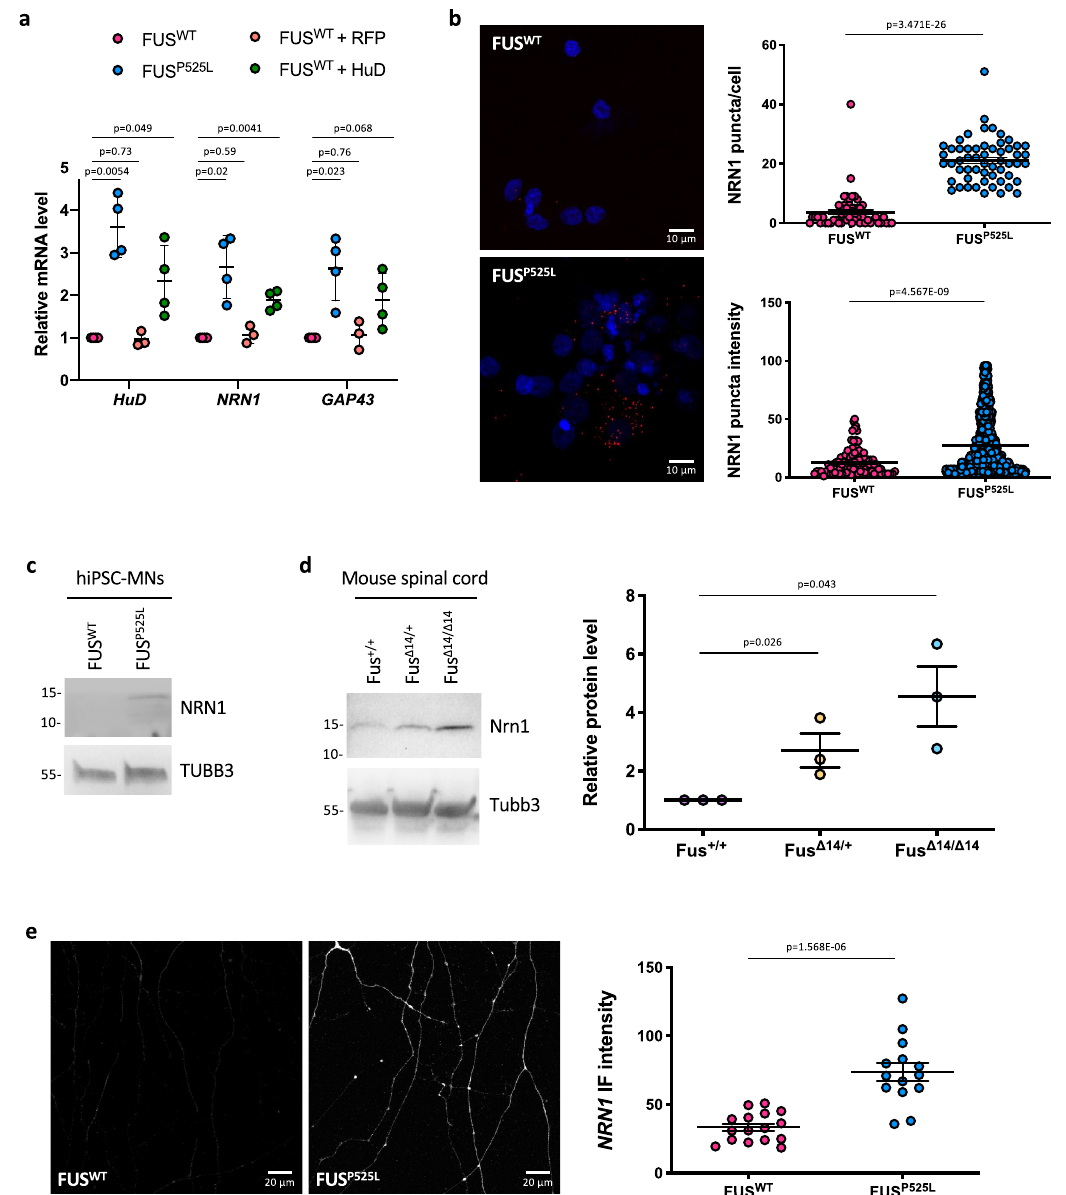
Fig. 6 NRN1 levels are increased in mutant FUS MNs. a Analysis of the mRNA levels of the indicated genes by real time qRT-PCR in FUS WT , FUS P525L and FUS WT overexpressing HuD or RFP, as a control, under the SYN1 promoter (FUS WT + HuD and FUS WT + RFP) hiPSC-derived spinal MNs. The graph shows the average from three or four independent differentiation experiments, error bars indicate the standard deviation (Student ’ s t -test; paired; two tails). b NRN1 mRNA analysis by FISH (red) in FUS WT and FUS P525L hiPSC-derived spinal MNs. DAPI (blue) was used for nuclear staining. Scale bar: 10 μ m. Graphs show the average count of HuD mRNA puncta per cell and the puncta intensity from three independent differentiation experiments, error bars indicate the standard error of the mean (Student ’ s t -test; unpaired; two tails). c , d NRN1 protein levels analysis by western blot in FUS WT and FUS P525L hiPSC-derived spinal MNs ( c ) and Fus- Δ 14 mouse model spinal cord ( d ). The molecular weight (kDa) is indicated on the left. The graphs show the average from three independent biological replicates, error bars indicate the standard deviation (ordinary one-way ANOVA; multiple comparisons). Tubb3 signal was used for normalization. Protein levels are relative to Fus + / + conditions. e Immunostaining analysis of NRN1 in axons of FUS WT and FUS P525L hiPSC- derived spinal MNs. The graph shows the NRN1 signal intensity from four replicates from two differentiation experiments, error bars indicate the standard error of the mean (Student ’ s t -test; unpaired; two